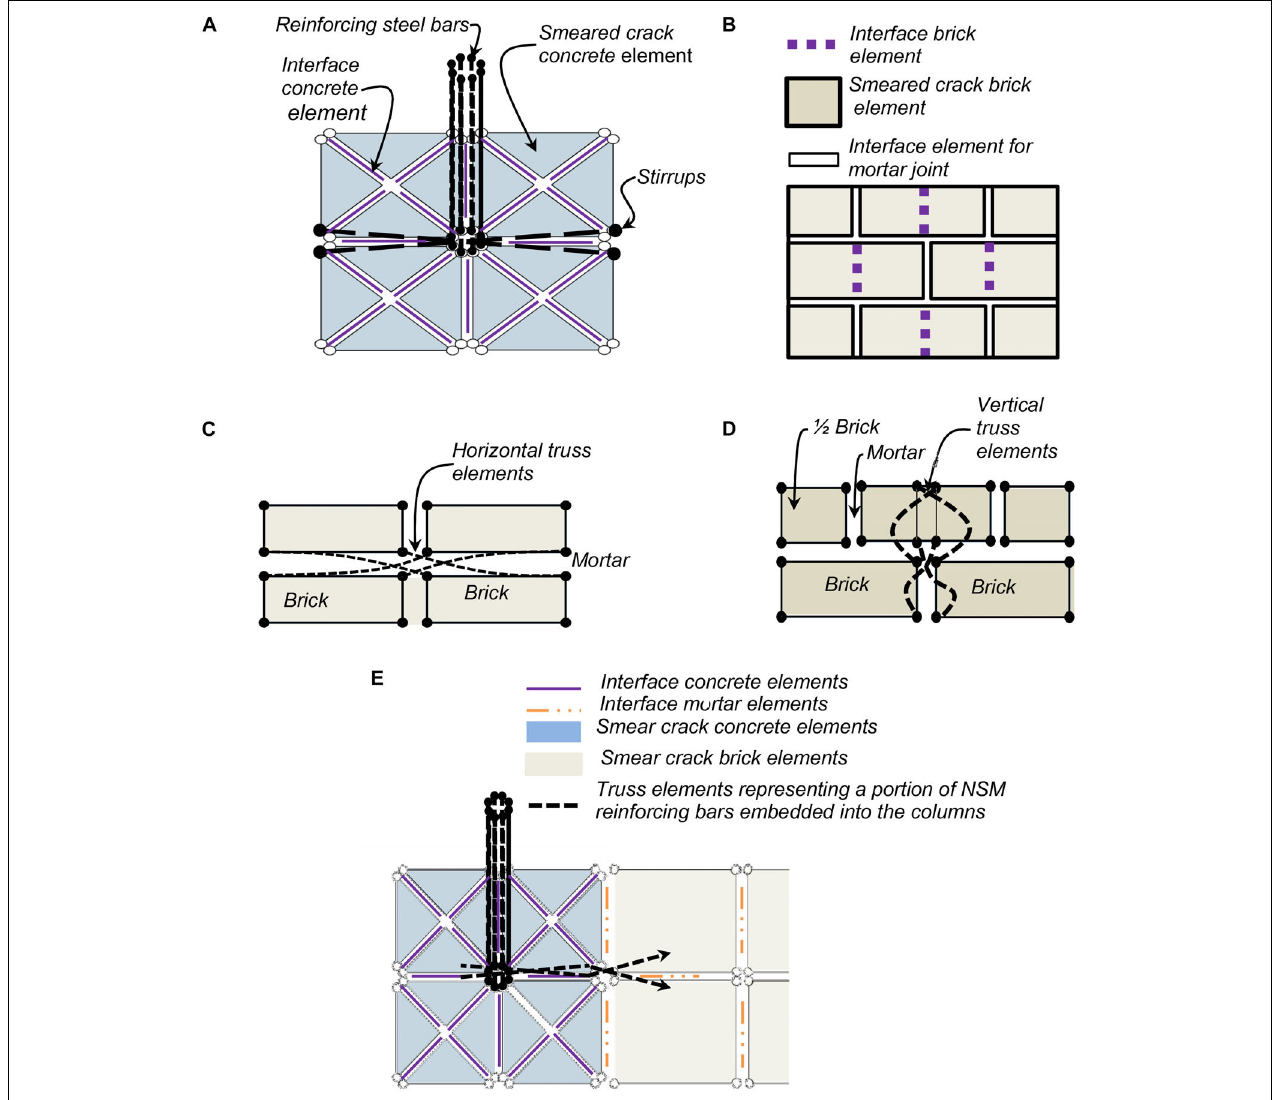
FIGURE 9 | FEM discretization: (A) RC section, (B) URM wall, (C) horizontal near-surface mounted (NSM) reinforcing bar (D) vertical NSM bars, and (E) NSM bars embedded into the concrete